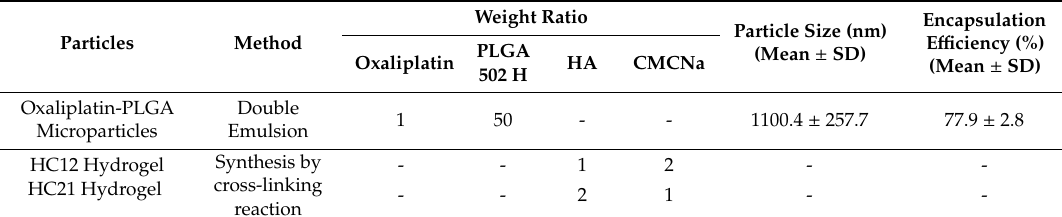
Table 1. Compositions and characterizations of Poly-( d , l -lactide- co -glycolide) (PLGA) microparticles and hyaluronic acid (HA) and carboxymethyl cellulose sodium (CMCNa)-based cross-linked (HC)